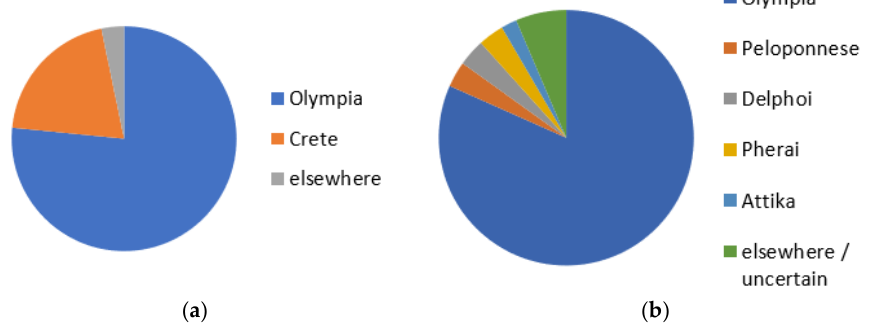
Figure 1. Provenance of bovine and equine figurines in Geometric Greece: ( a ) cows; ( b ) horses.